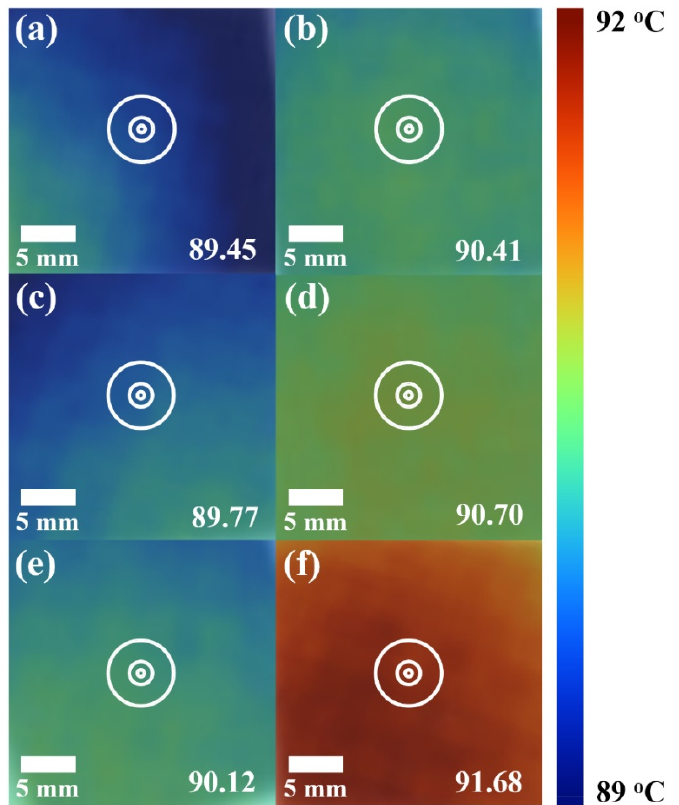
Figure 5. Thermal images of the composites with M5 ( a ) 10 wt.% and ( b ) 30 wt.%; M15 ( c ) 10 wt.% and ( d ) 30 wt.%; and M25 ( e ) 10 wt.% and ( f ) 30 wt.%.